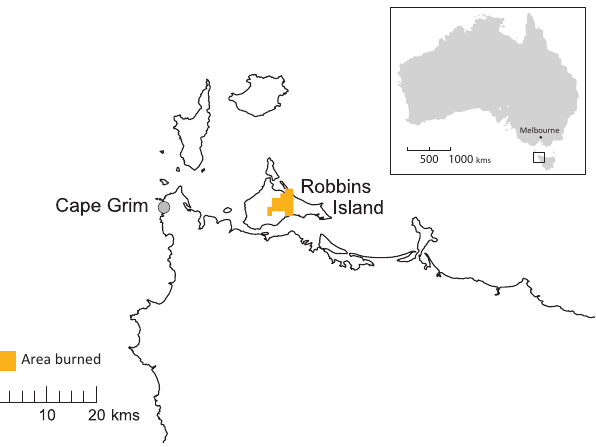
Figure 1. Location of Cape Grim and Robbins Island in North West Tasmania, Australia. Area burned is